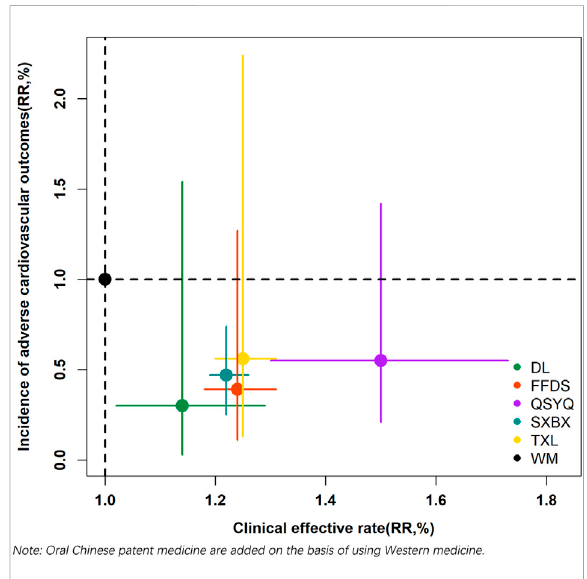
FIGURE 5 Two-dimensional graph. WM, Western medicine; FFDS, Fufang Danshen dripping pill; DL, Danlou tablet; QSYQ, Qishen Yiqi dripping pill; SXBX, Shexiang Baoxin pill; TXL, Tongxinluo